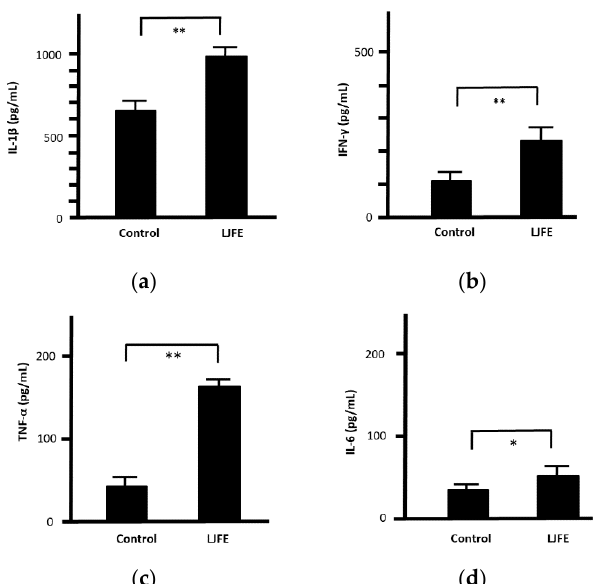
Figure 5. Effects of Lonicera japonica flower bud extract (LJFE) on mice serum cytokine levels. Mice were orally administered LJFE (2 g/kg) for seven days, and the serum levels interleukin ( a ) (IL)-1 β , ( b ) interferon (IFN)- γ , ( c ) tumor necrosis factor (TNF)- α , and ( d ) IL-6 were measured by ELISA. Data are presented as mean ± S.D. ( n = 6). * p < 0.05, ** p < 0.01, t -test.